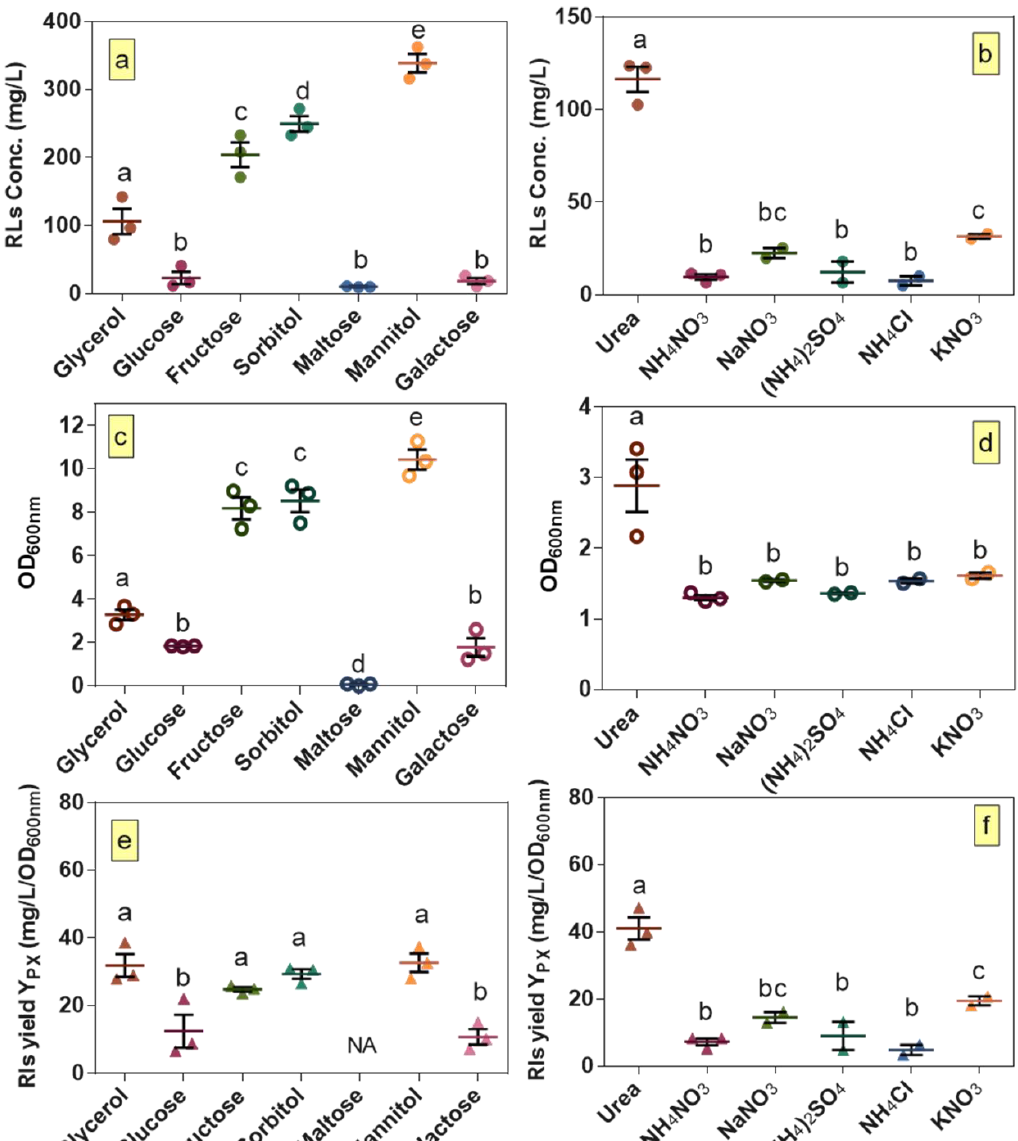
Figure 1. Growth, production and yield per biomass of rhamnolipids for B. glumae BGR1 grown on different carbon and nitrogen sources. Production: ( a ) carbon; and ( b ) nitrogen; growth: ( c ) carbon; and ( d ) nitrogen; and yield per biomass: ( e ) carbon; and ( f ) nitrogen. ( a , c , e ) For carbon source screening, urea was the nitrogen source; and ( b , d , f ) for nitrogen source screening, glycerol was used as the carbon source. Statistical difference was determined using an ANOVA followed by Duncan’s multiple range test. Different lower-case letters indicate statistically significant differences ( p < 0.05). The error bars indicate the standard error of the mean ( n = 2–3). NA stands for not applicable.